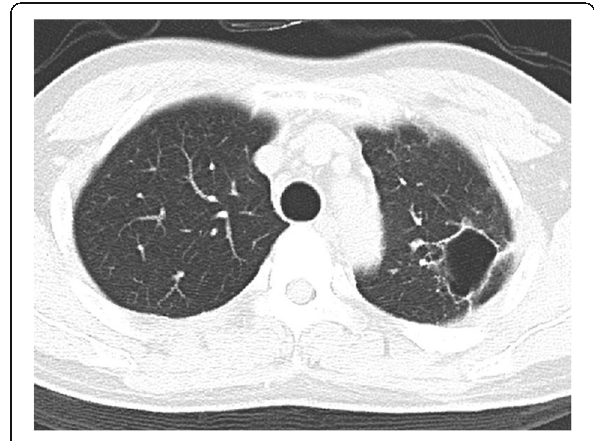
Fig. 4 Computed tomography findings after 7 months. The lung abscess is completely cured with a small residual thin wall